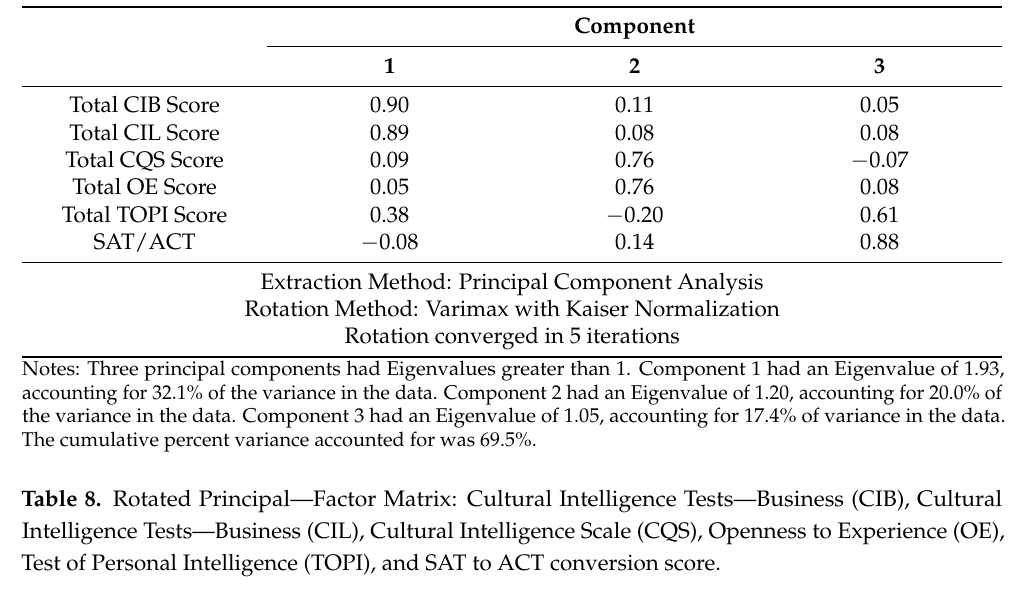
Table 7. Rotated Principal—Component Matrix: Cultural Intelligence Tests—Business (CIB), Cultural Intelligence Tests—Business (CIL), Cultural Intelligence Scale (CQS), Openness to Experience (OE), Test of Personal Intelligence (TOPI), and SAT to ACT conversion score.